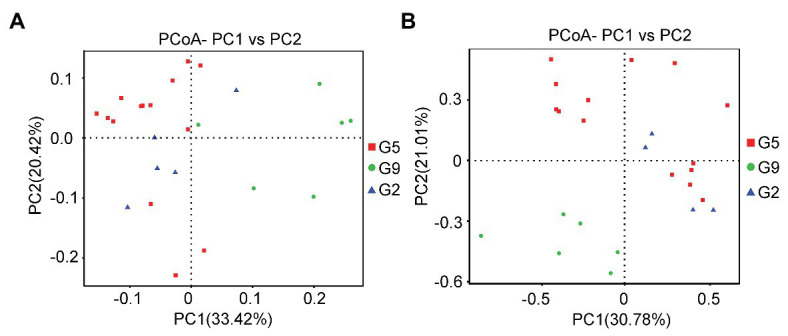
Different analyses of the microbial community structures based on operational taxonomic units (OTUs). (A) Principal coordinates analysis (PCoA) graph based on the 16S rDNA sequence. (B) PCoA graph based on the ITS1 sequence.